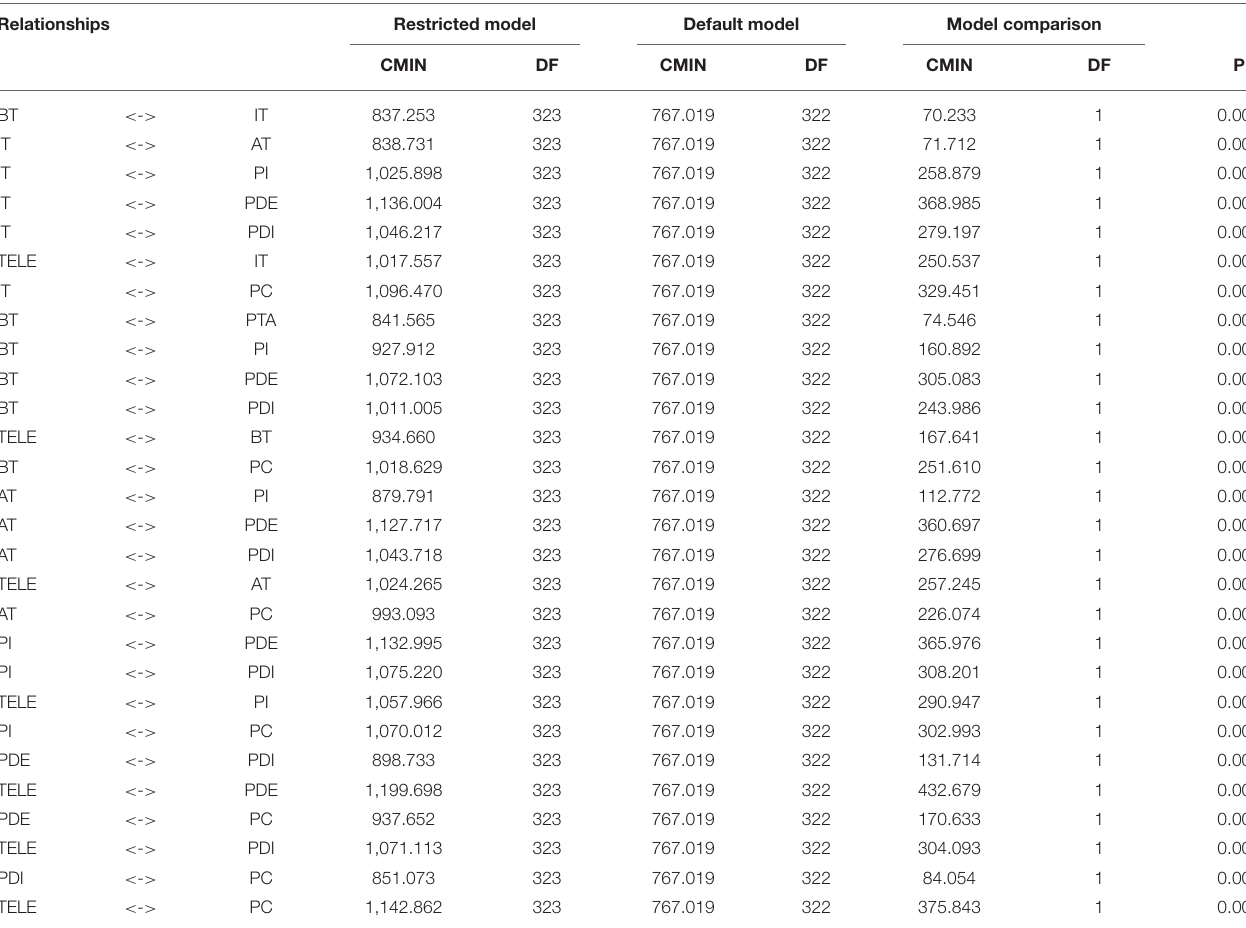
TABLE 3 | Results for further discriminant validity test ( N = 406).